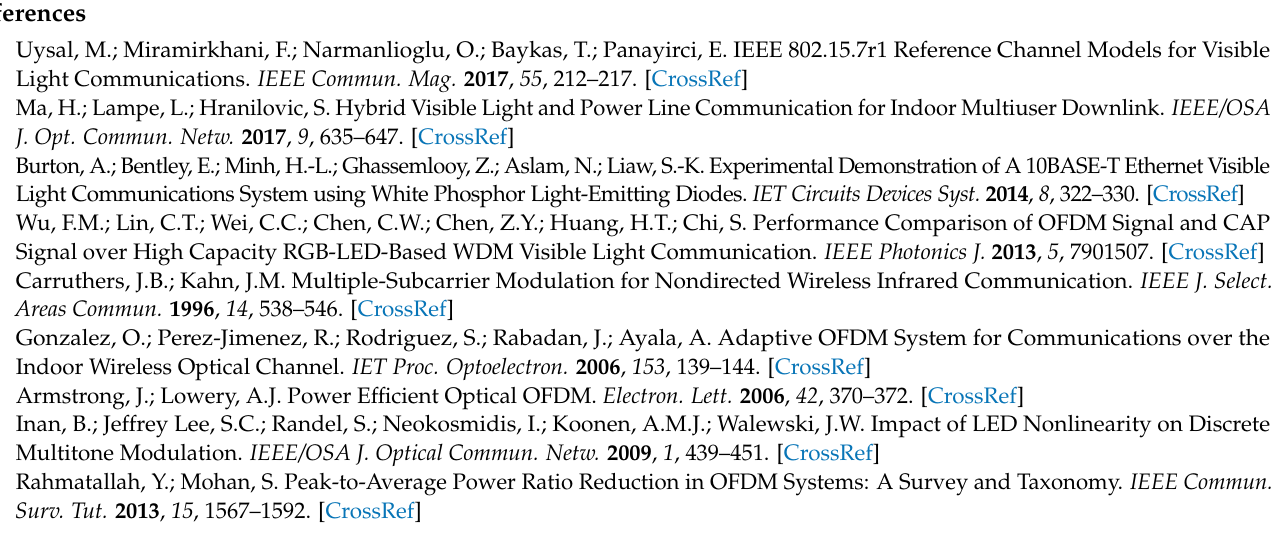
Figure 14. BER versus the distance between the LED and the PD of the 64 QAM modulated OFDM for the NLMS, the Chebyshev polynomial, and the proposed ANN predistortion.